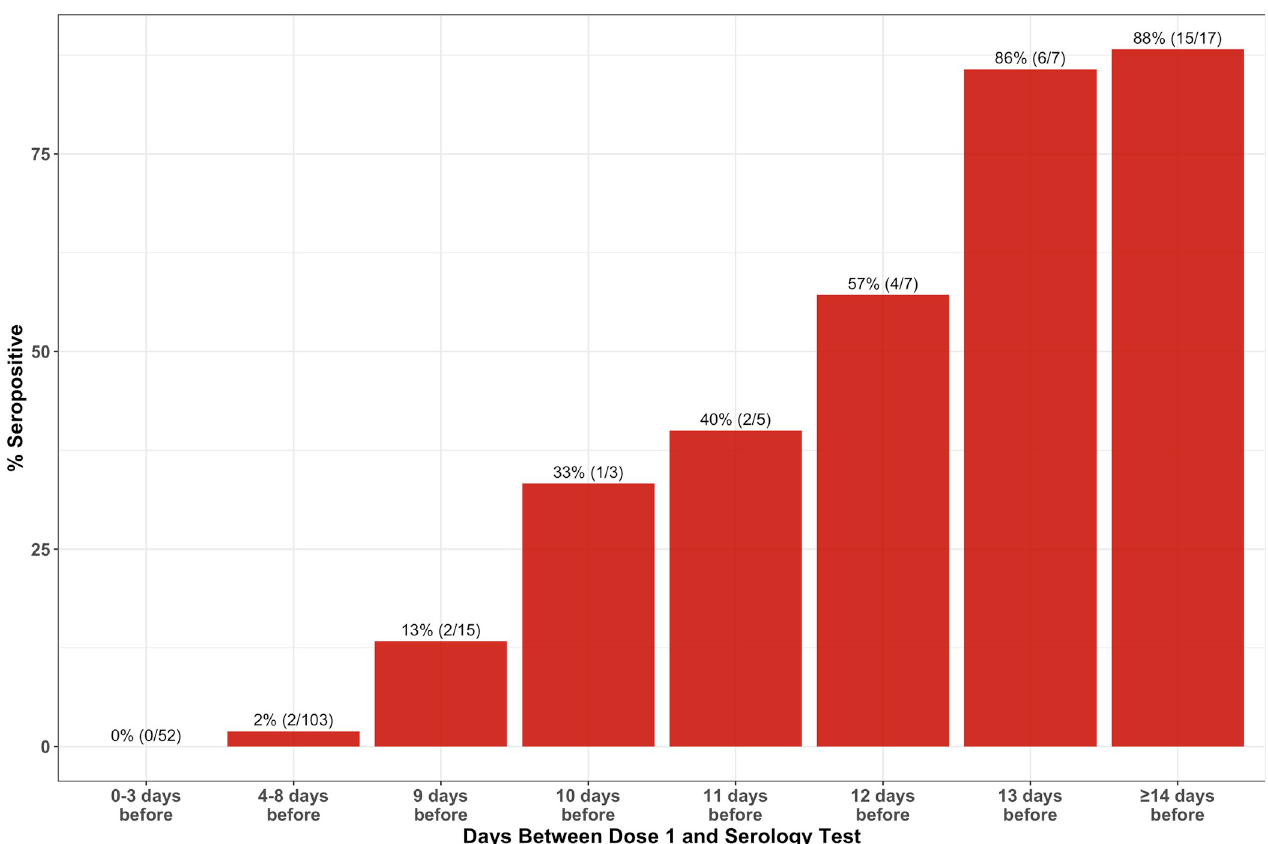
Fig 5. SARS-CoV-2 seroprevalence according to time from vaccination among vaccinated individuals. %(N/total) presented above each bar.